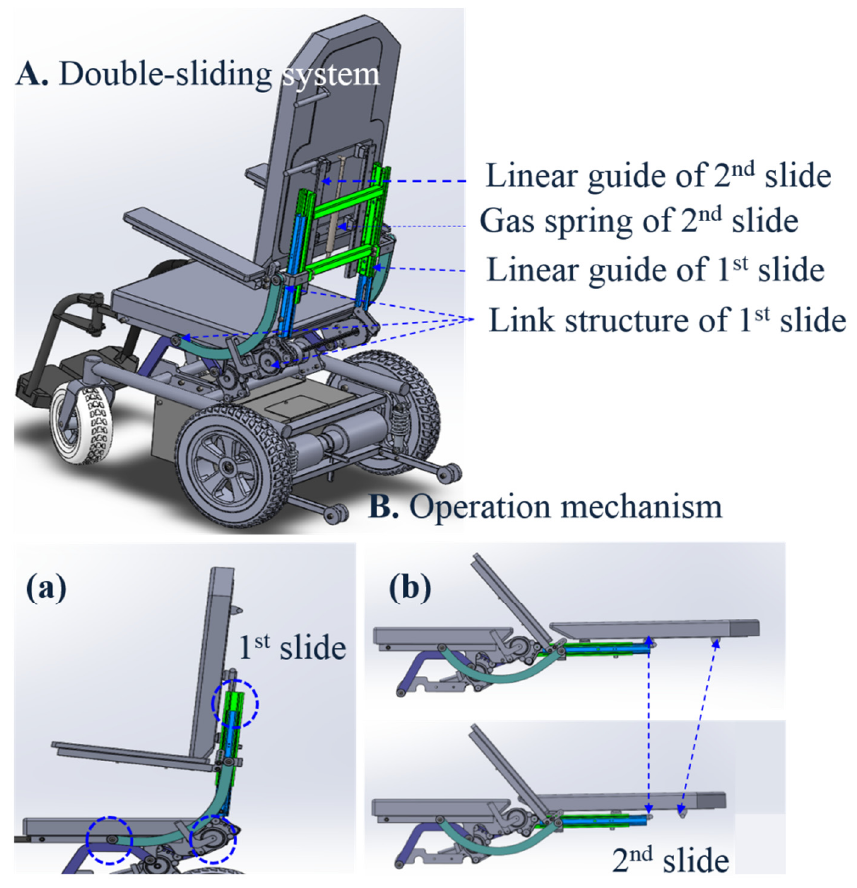
Figure 3. Designed double-sliding recline system ( A ) and operation mechanism ( B ): Detailed schematic diagram of the operation of the 1st slide ( a ) and the 2nd slide ( b ).